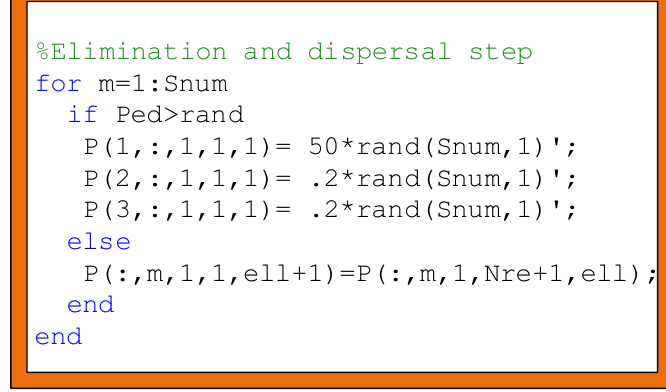
Figure 5. The code block representing the elimination and dispersal step.